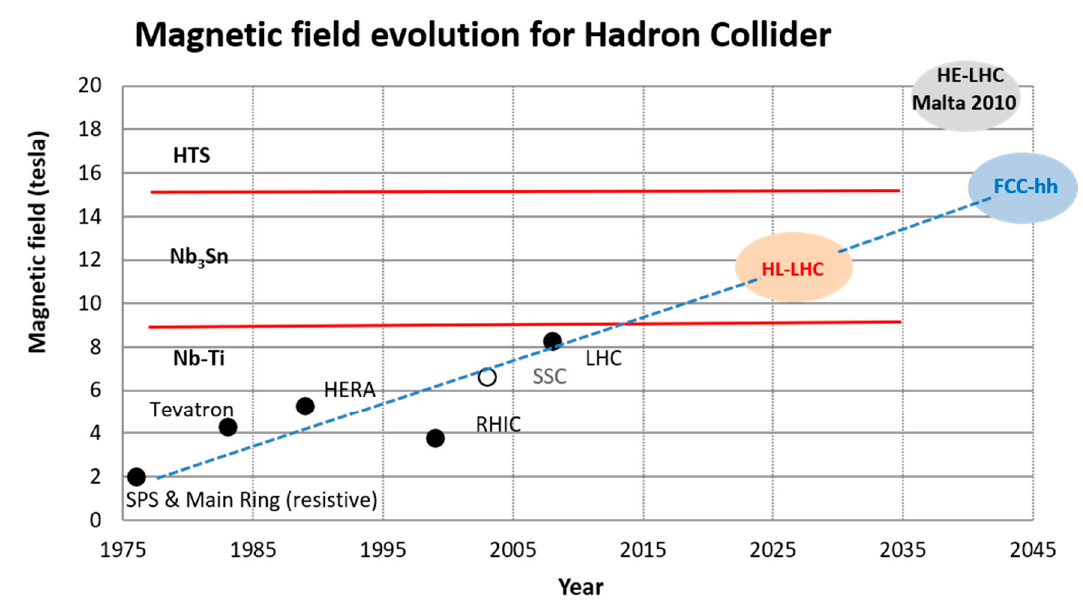
Figure 1. Progress of the operating field in circular hadron colliders (ill-fated SSC, i.e., the Superconducting Super Collider, is reported for comparison). LHC dipoles are actually working at 7.7 T and are supposed to operate at 8.3 T design field in 2022–2023. HL-LHC has already shown its field level in a few prototypes. HE-LHC (Malta workshop 2010) is a pure paper design. FCC-hh started dedicated R&D in 2014.